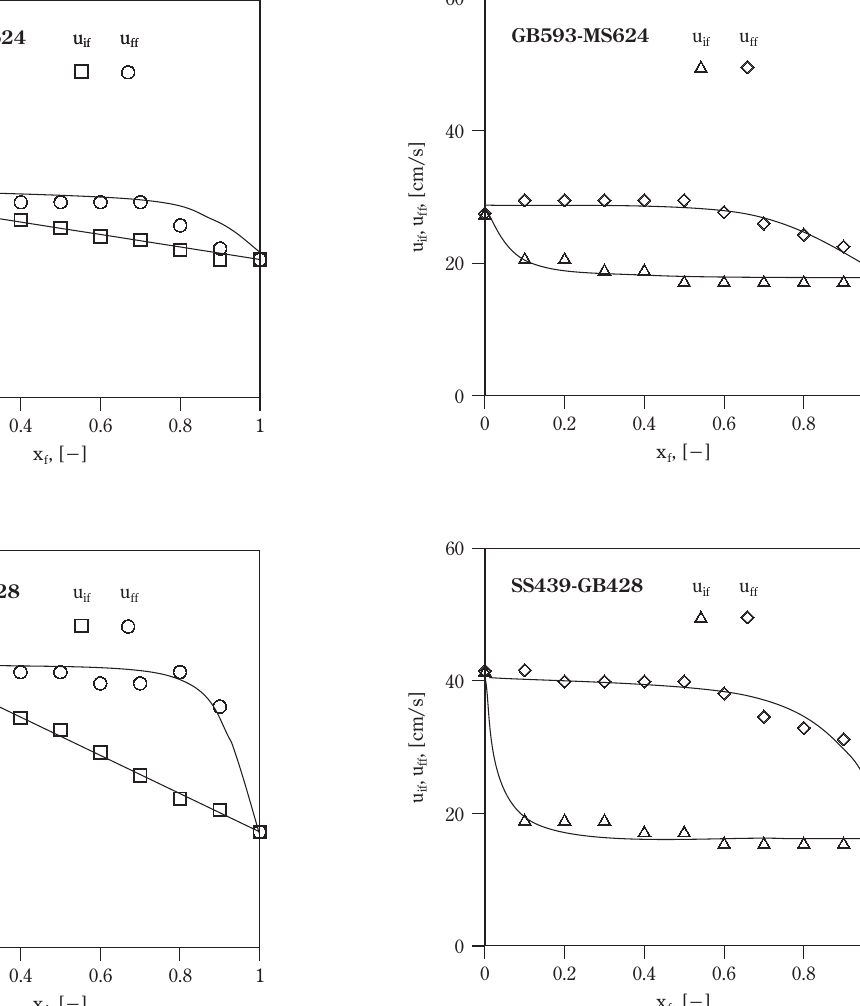
Fig. 8 for the initially segregated one.